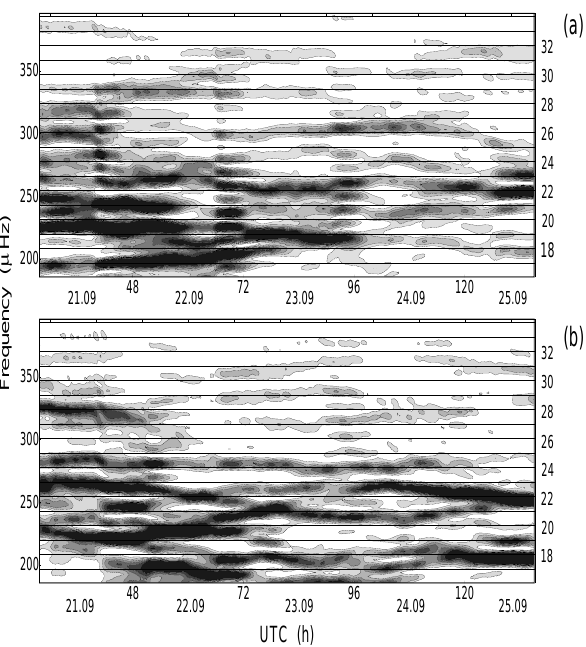
Fig. 4. As for Fig. 3 but in the 2.5–5h period range during 29 October–4 November